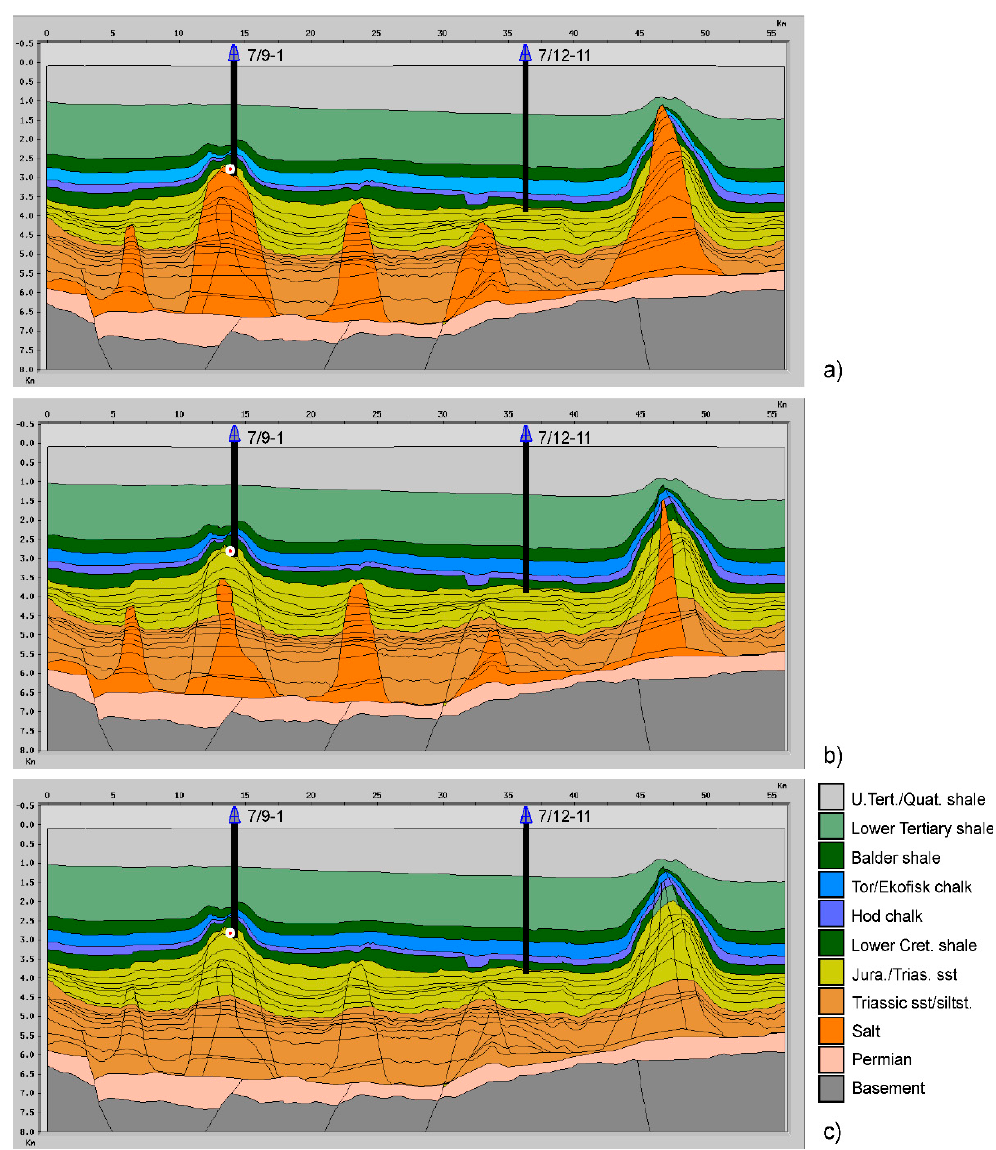
Figure 13. Present day geometry input of Model 2, colored by lithology. From top: ( a ) Maximum-salt model; ( b ) minimum-salt model; and ( c ) no-salt model. The locations of wells 7 / 9-1 and 7 / 12-11 are projected onto the profile.